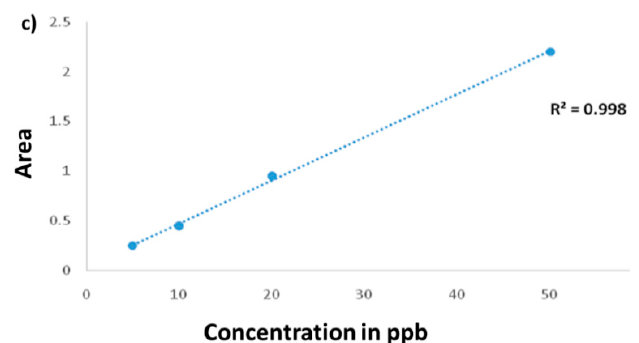
Figure 1. HPLC standard calibration curves for ( a ) ampicillin standards at 50, 100, 150, 200, and 250 ppb; ( b ) nalidixic acid at 1, 5, 10, 20, 30, and 50 ppb; ( c ) sulfadoxine at 5, 10, 20, and 50 ppb.